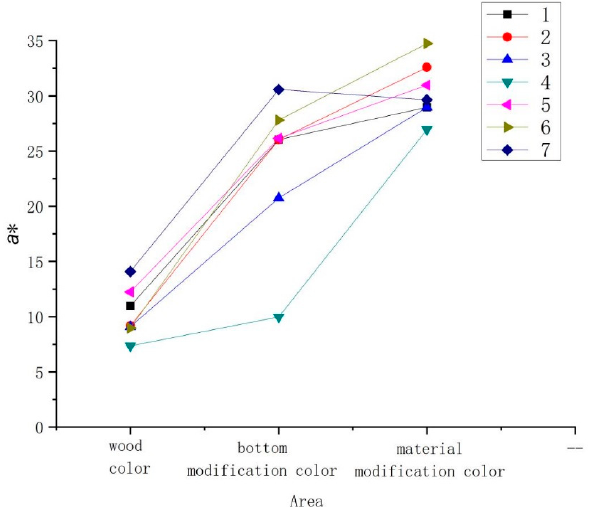
Figure 2. The influence of the coloring of specimens in different regions on a *.